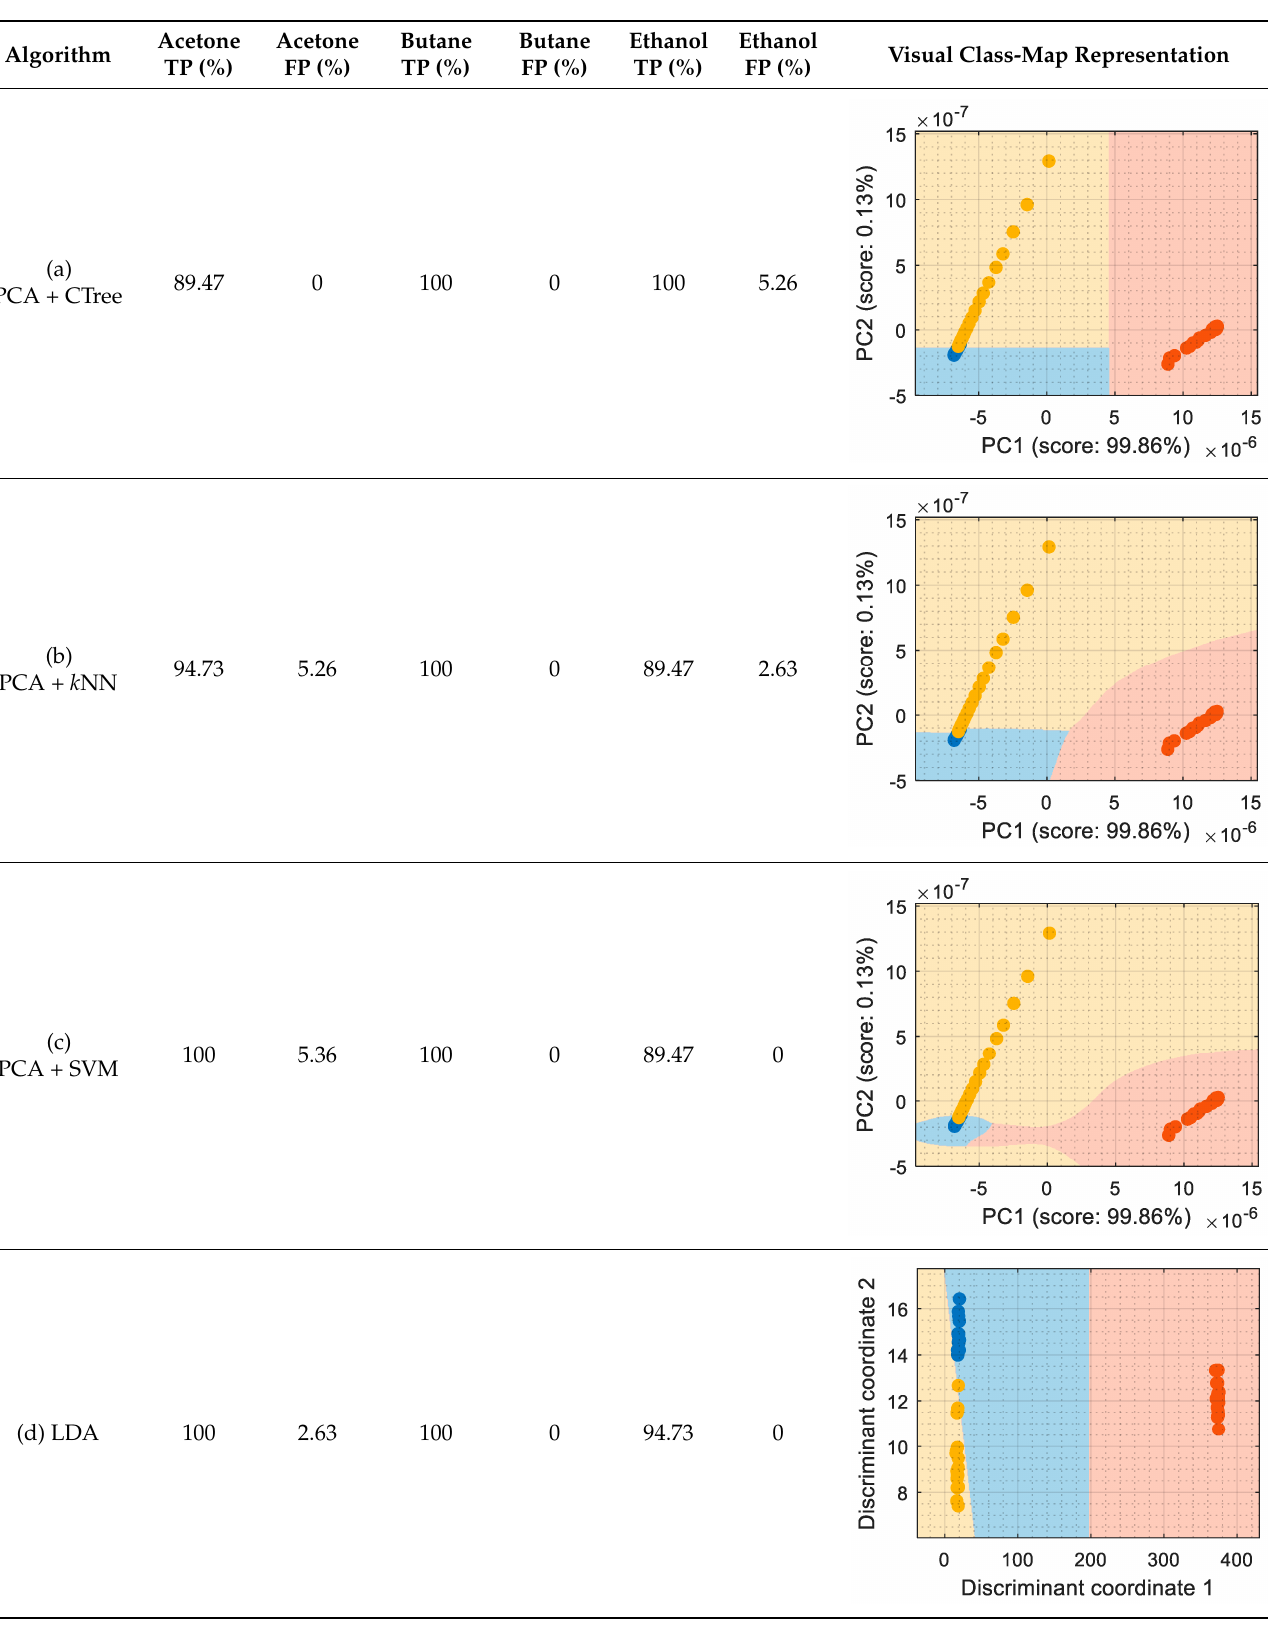
Table 2. Performance of the classifiers when processing the information gathered from the eNose as conductance: representations of true positive (TP) and false positive